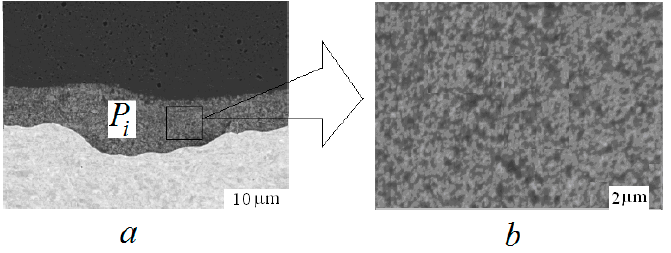
Figure 12. The interlayer in the weld zone melted zone (( a ) view at the distance, ( b ) zoomed).